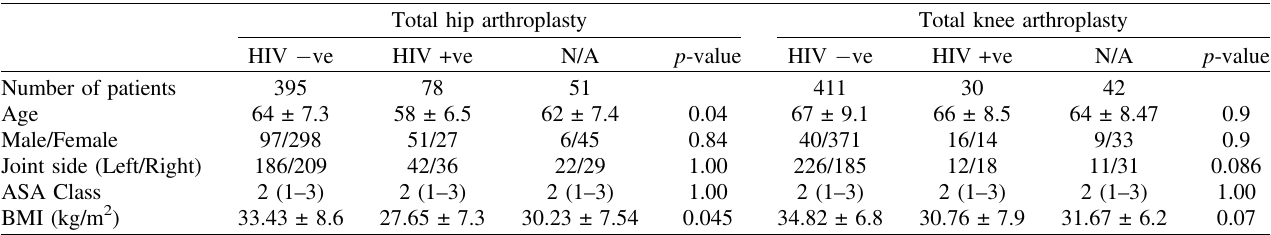
Table 1. Demographic results of total joint arthroplasty population,